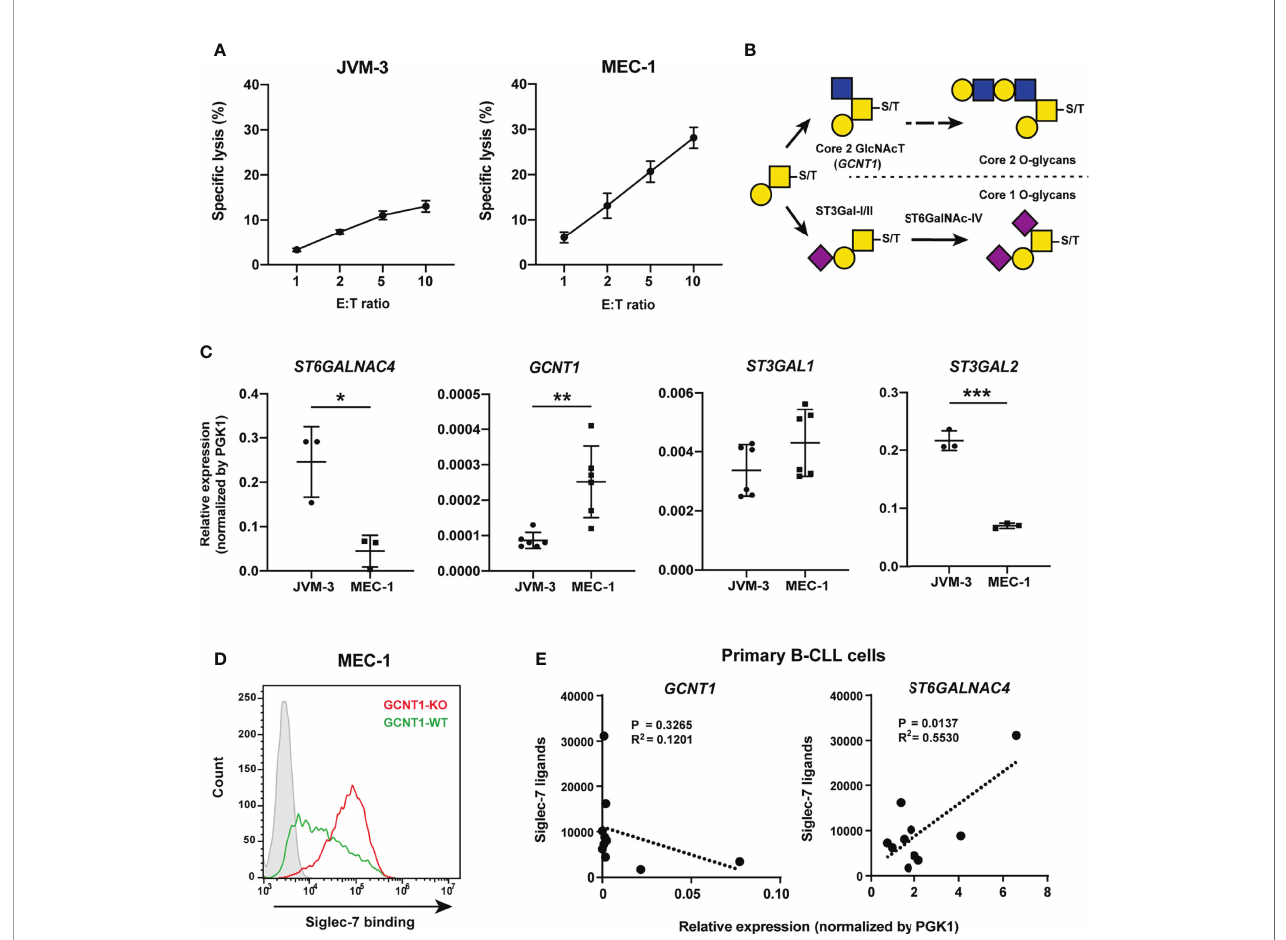
FIGURE 6 | Core 2 GlcNAc transferase interferes with the biosynthesis of the glycotope recognized by Siglec-7. (A) NK cell cytotoxicity assay of JVM-3 and MEC-1 cell lines. JVM-3 cells were more resistant than MEC-1 cells to NK cell cytotoxicity. Cytotoxicity assays were conducted in technical triplicate and repeated several times, with consistent results. Representative results are shown. Bars represent mean ± SD of technical triplicates. (B) Schematic representation of O-glycan biosynthesis in leukocytes. (C) Quantitative real-time polymerase chain reaction analysis of glycosyltransferases in JVM-3 and MEC-1 cells. ST6GALNAC4 expression was higher in JVM-3, whereas GCNT1 expression was higher in MEC-1 (* P < 0.05, ** P < 0.01, and *** P < 0.001; Student ’ s t test). Bars represent mean ± SD of technical replicates (n = 3 – 6). (D) Effect of GCNT1 disruption in MEC-1 cells on Siglec-7 – Fc binding. (E) Correlation of the GCNT1 and ST6GALNAC4 transcript levels and Siglec-7 – Fc binding (in median fl uorescence intensity [MFI]) to B cells from patients with chronic lymphocytic leukemia (n = 10). Association between gene expression and Siglec-7 binding was analyzed by linear